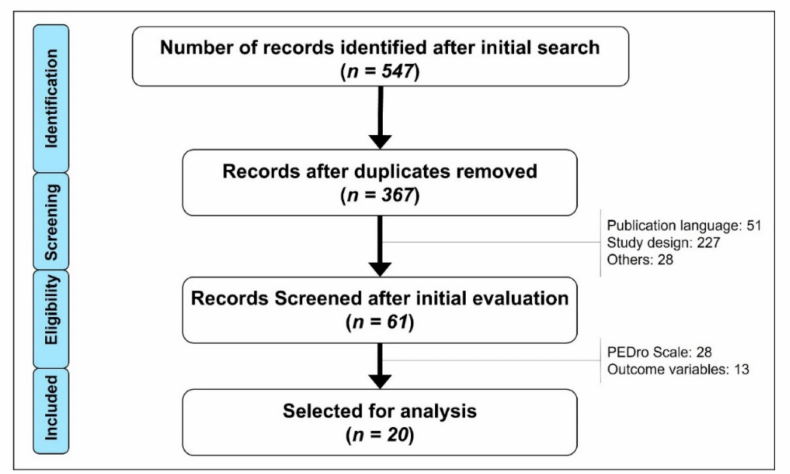
Figure 1. Flow chart of the search, filtering and selection of the included